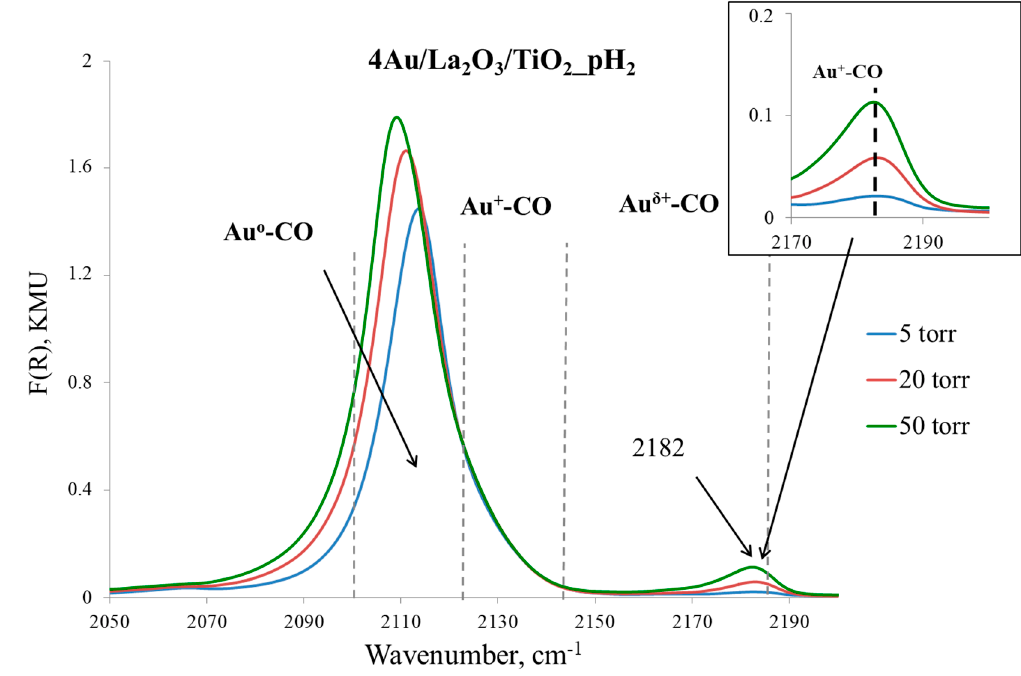
Figure A2. DRIFT spectra of CO adsorbed on the most active catalysts in peroxidative and aerobic oxidation of 1-phenylethanol. Reproduced from Ref. [43] with permission from the Royal Society of Chemistry, 2019.